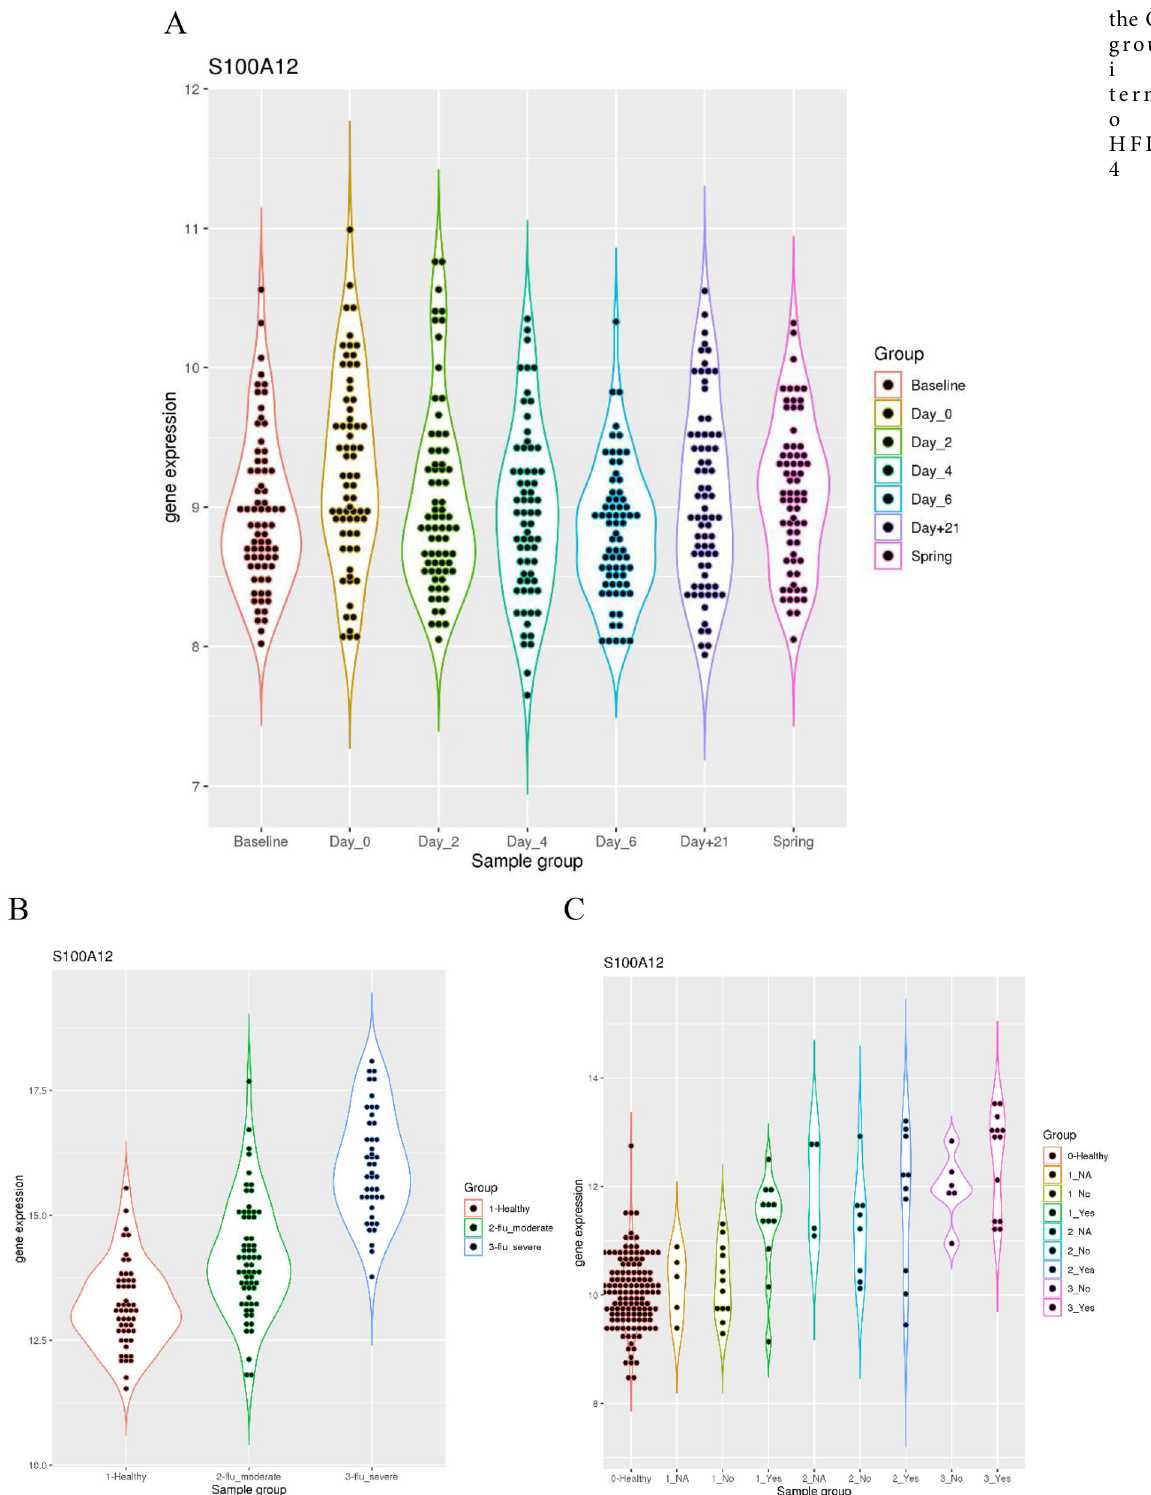
Figure 3. S100A12 as an indicator of the severity in influenza infection. ( A ) upper panel, comparison of S100A12 expression in patients with mild influenza infection throughout a whole year of community monitoring (prior to and after the infection onset, and follow-up in the next spring). ( B ) lower left, comparison of S100A12 expression in healthy controls and patients with moderate or severe influenza infection. ( C ) lower right, comparison of S100A12 expression in healthy controls and patients with influenza infection at three severity levels. Some of the patients have known status of bacterial infection (Yes or No) while others don’t